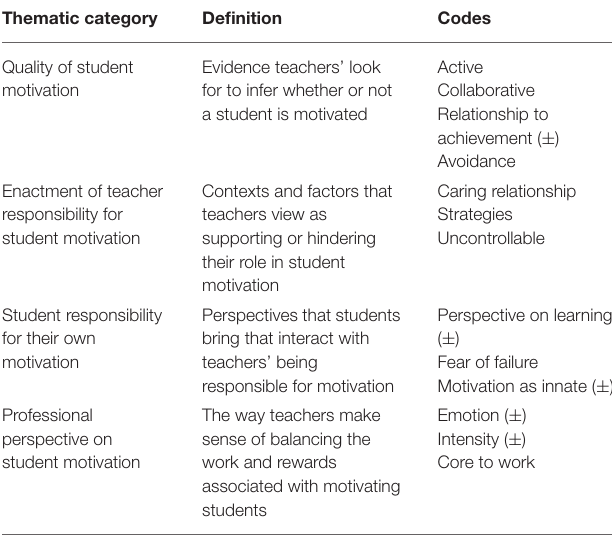
TABLE 2 | Qualitative thematic categories related to feeling personally responsibility for student motivation in the qualitative strand ( n = 6). Thematic